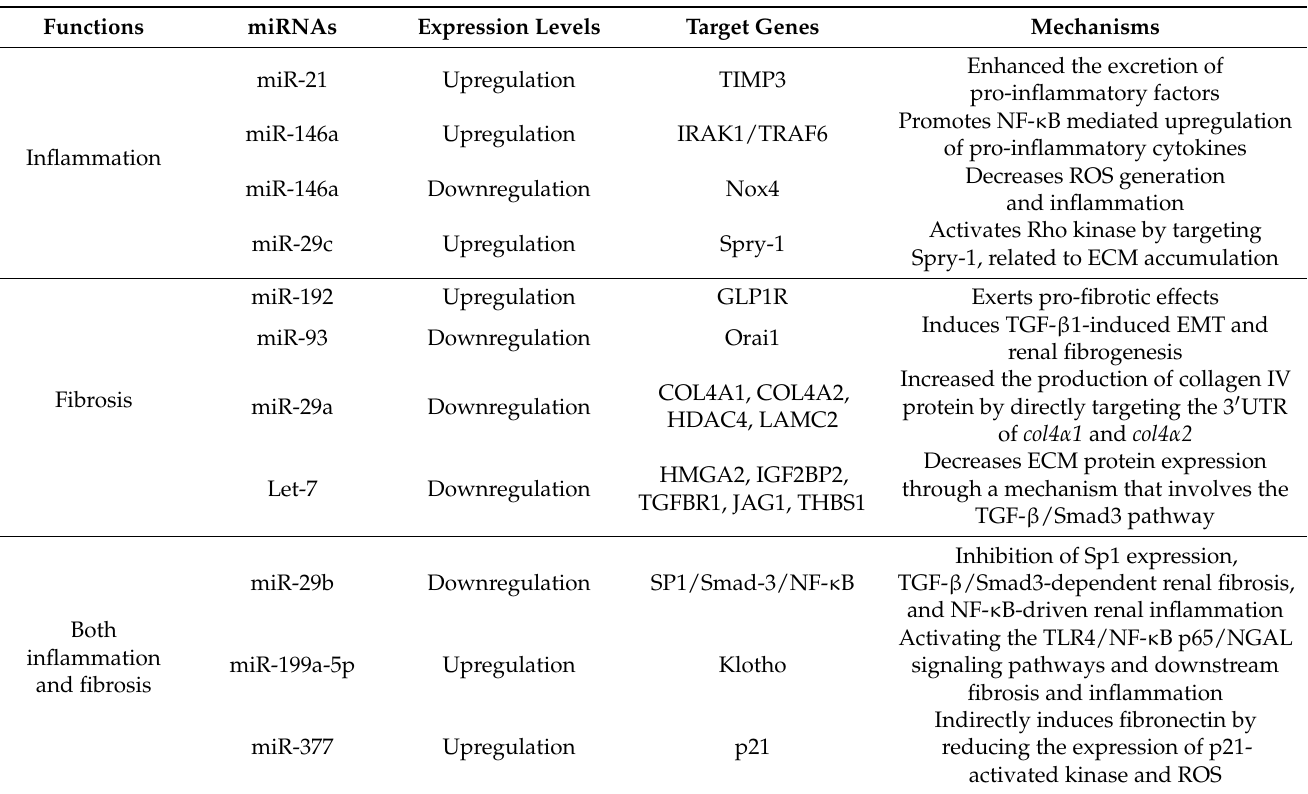
Table 1. Some miRNAs involved in diabetes-related renal inflammation and